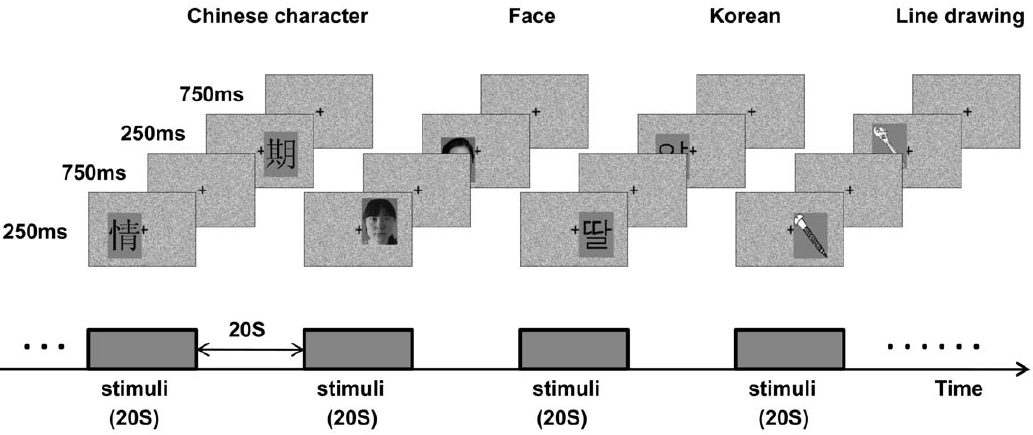
Figure 1. Schematic depiction of the experimental paradigm. In block-design runs, subjects viewed Chinese characters, Korean characters, unfamiliar faces and line drawings in separate blocks. In each block 20 stimuli were presented and each stimulus was presented for 250 ms with an inter-stimulus interval of 750 ms. Each run contained 12 blocks with 3 blocks for each category of stimuli.